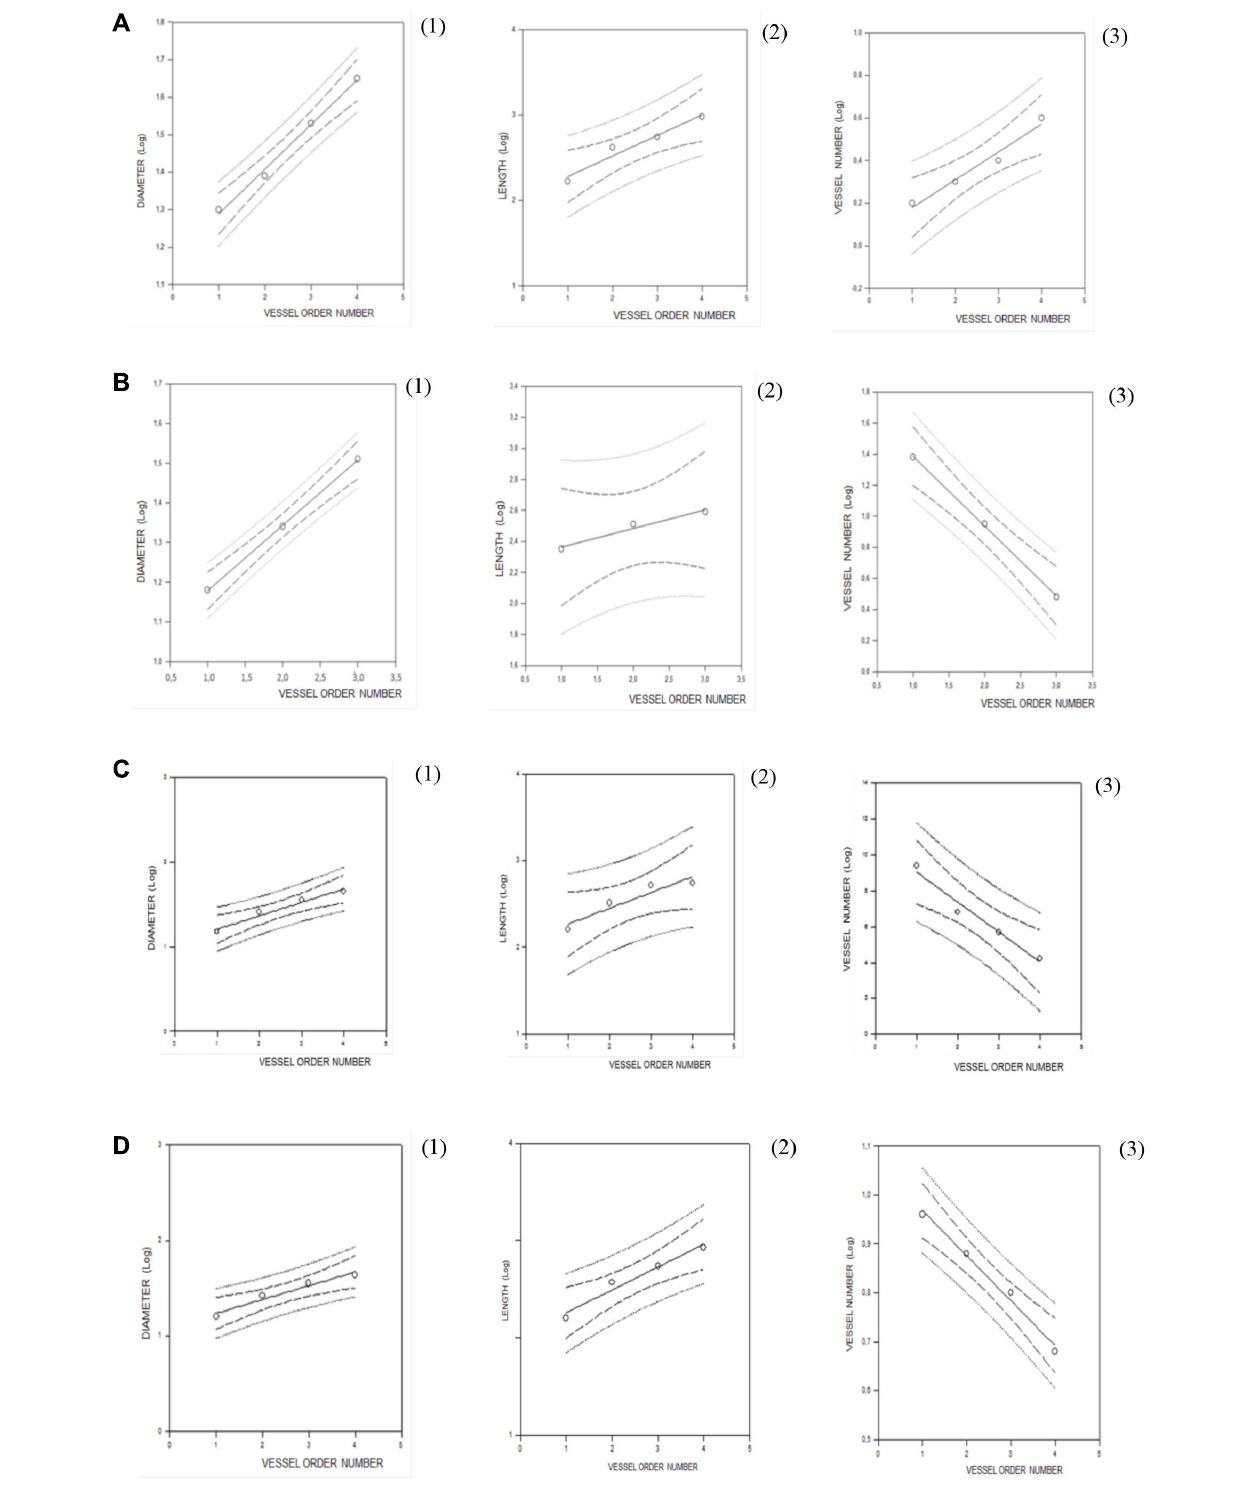
FIGURE 2 | Regression lines developed from relationships between the mean diameter logarithm ( 1 ), length logarithm ( 2 ), logarithm of the vessel element number in successive orders of vessels ( 3 ), and arteriolar order number for young spontaneously hypertensive rats (SHRs) (A) , young normotensive age-matched rats (B) , adult SHRs (C) , and adult normotensive age-matched rats (D)